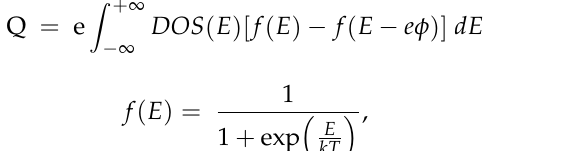
where e is the electronic charge, f ( E ) is the Fermi-Dirac distribution function and E is the energy w.r.t the Fermi